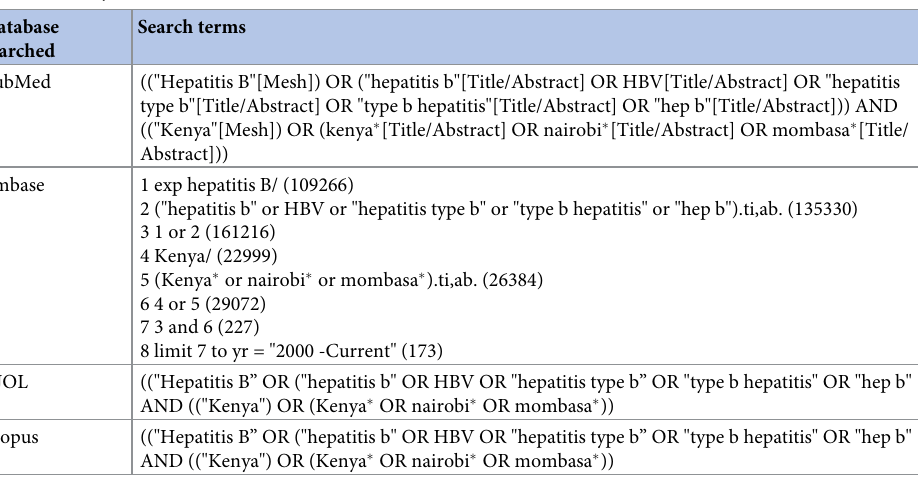
Table 1. Search terms for online databases used during a systematic review on HBV prevalence and genetic infor- mation in Kenya. Database